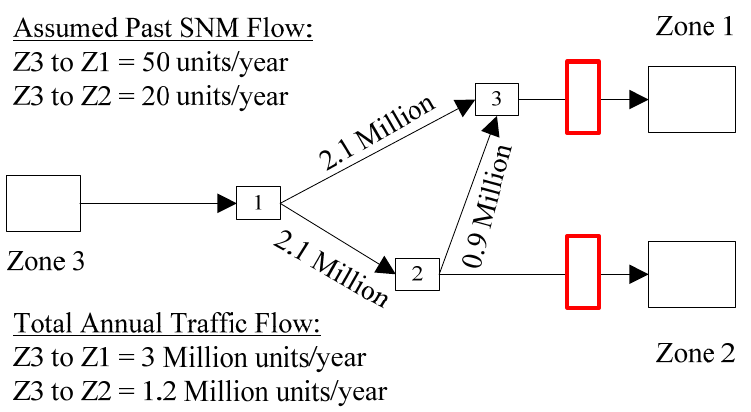
Figure 2. Example case to explain Kalman